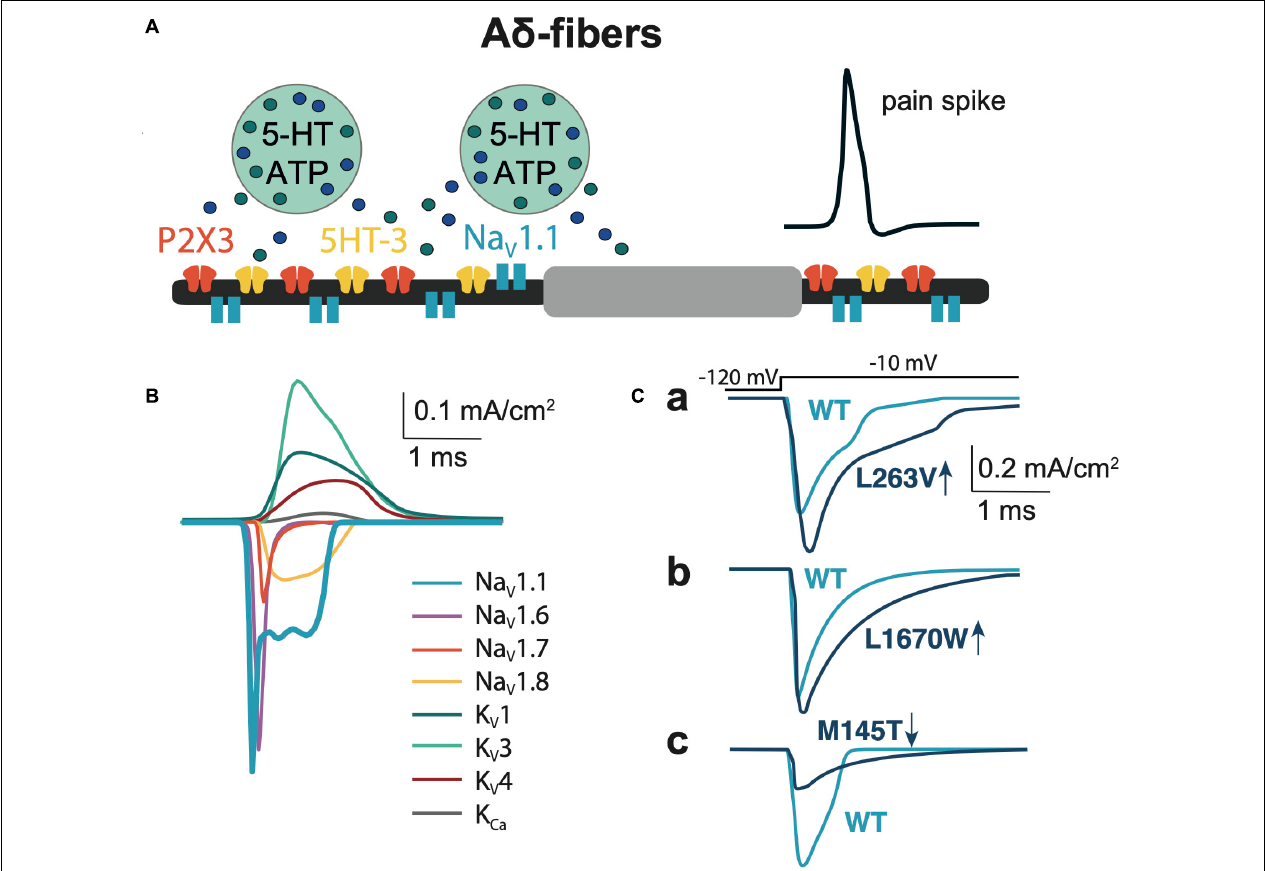
FIGURE 1 | Model of A δ -fiber. (A) Schematic presentation of the A δ -fiber with the diameter 5 µ m and node of Ranvier 2 × 2 µ m. (B) The membrane Na V , K V , and K Ca currents relevant to the model of A δ -fiber. (C) Comparison of Na V 1.1 currents, that evoked by a voltage step to -10 mV of WT with the L263V (Ca) , L1670W (Cb) , and M145T (Cc)